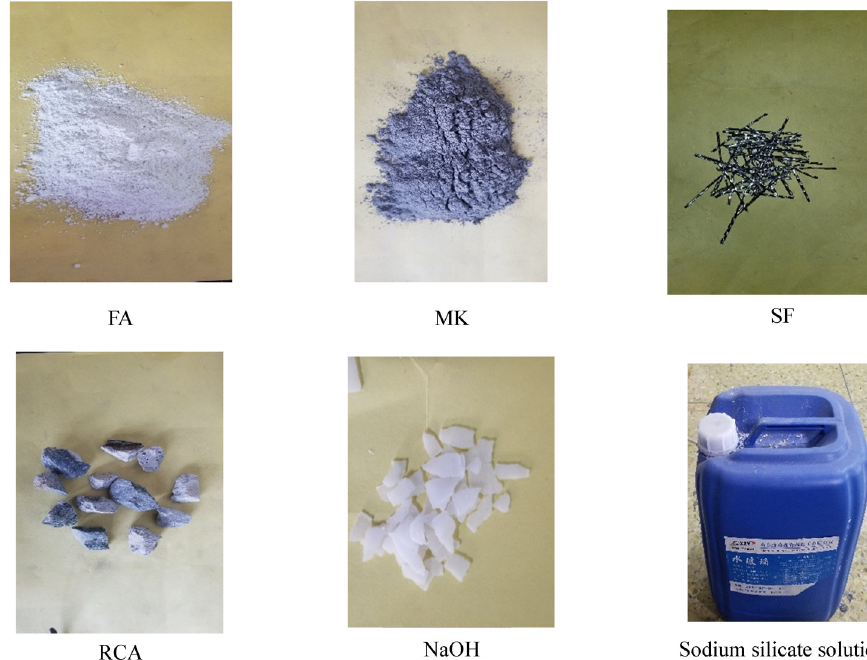
Figure 1: Photographs of materials.